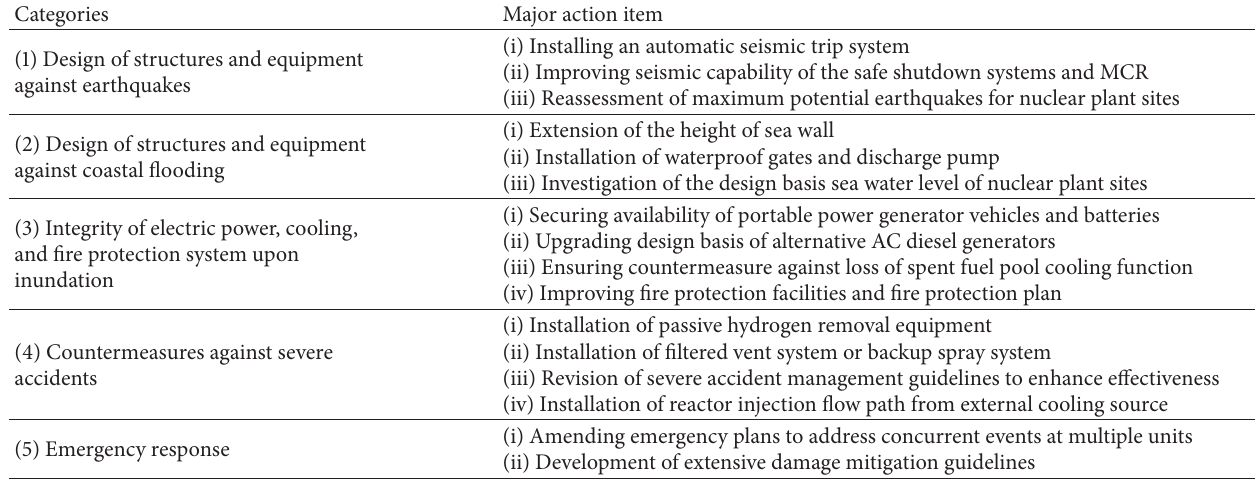
Table 1: Safety improvement action items in Korea after Fukushima accidents.